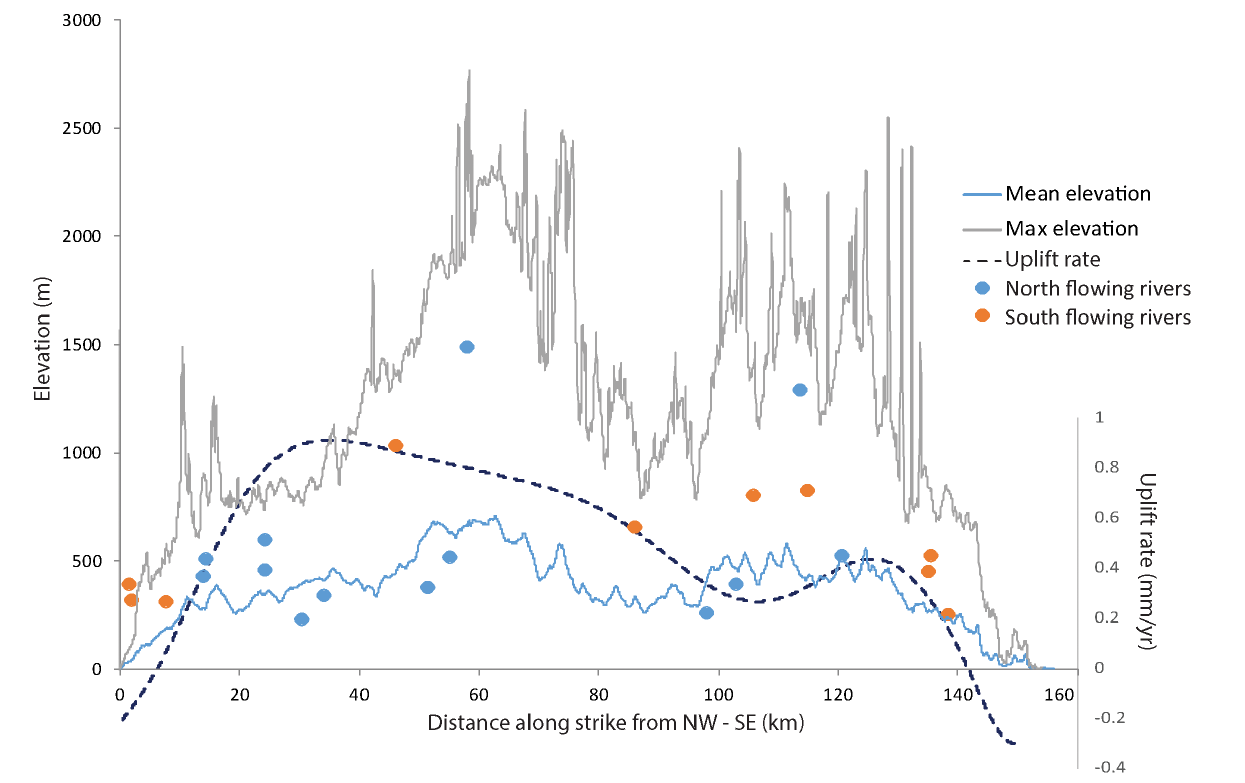
FIGURE 7 | Graph showing the distance along the strike of the island axis from NW – SE against mean (blue) and maximum (gray) elevation, knickpoint elevation (blue north/orange south) and interpolated uplift field for the island of Guadalcanal. Note that the maximum elevation value are affected by errors in the DEM.